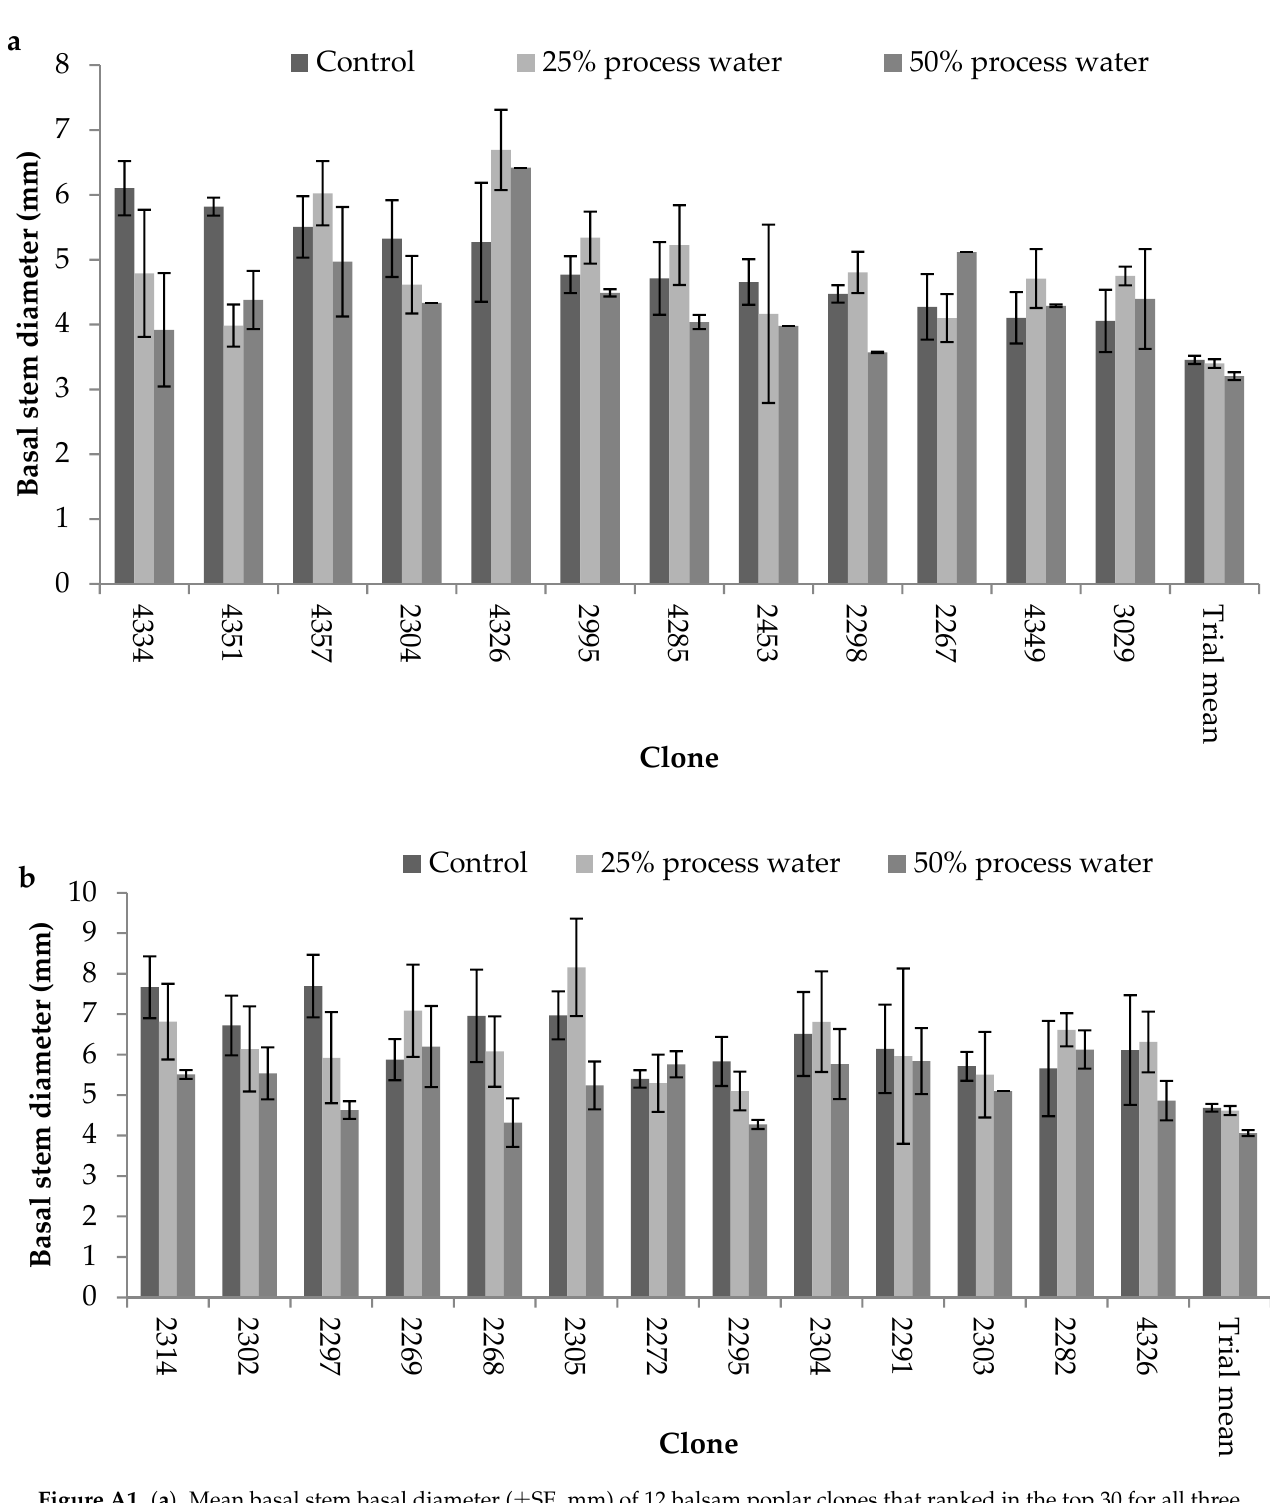
Figure A1. ( a ). Mean basal stem basal diameter ( ± SE, mm) of 12 balsam poplar clones that ranked in the top 30 for all three water treatments as compared with the overall trial mean for 148 clones after 44 days of growth in the 2012 experiment. ( b ). Mean basal stem basal diameter ( ± SE, mm) of 11 clones that ranked in the top 30 for all three water treatments as compared with the overall trial mean for 86 clones after 65 days of growth in the 2013 experiment.